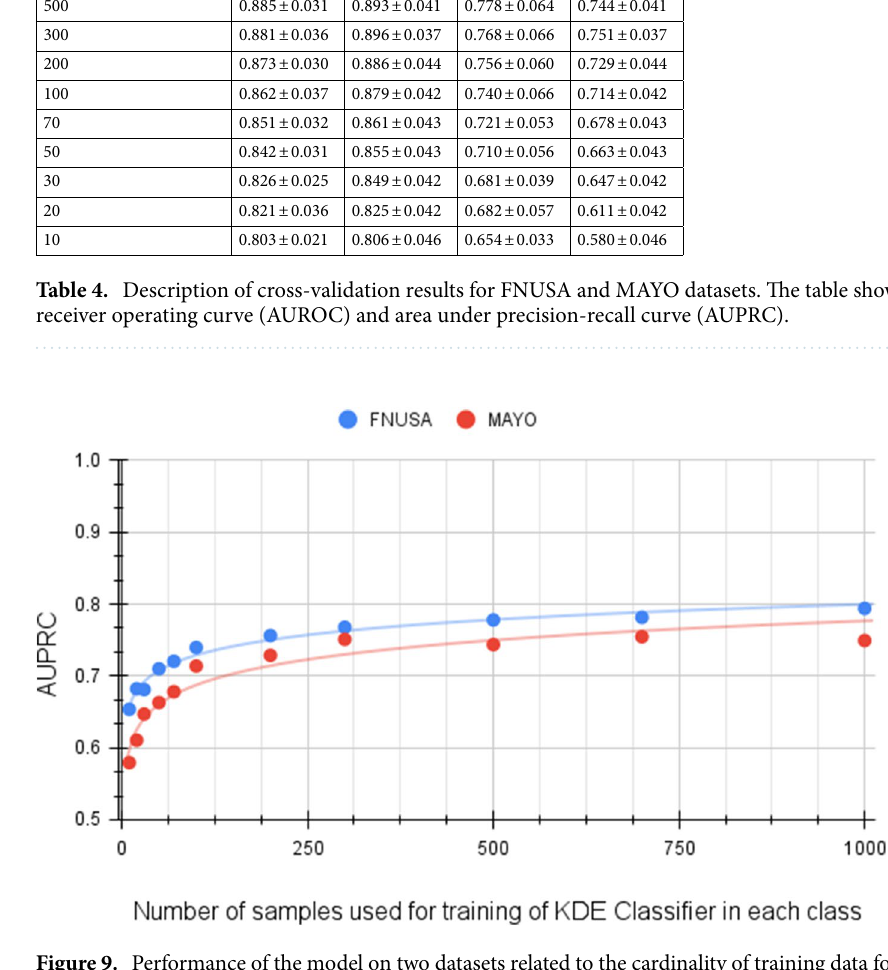
Figure 9. Performance of the model on two datasets related to the cardinality of training data for kernel density estimates (KDE) classifier. The plot shows the area under the precision-recall curve (AUPRC) metrics. The picture shows that 100 training examples per class achieve good model performance while requiring a reasonable amount of training